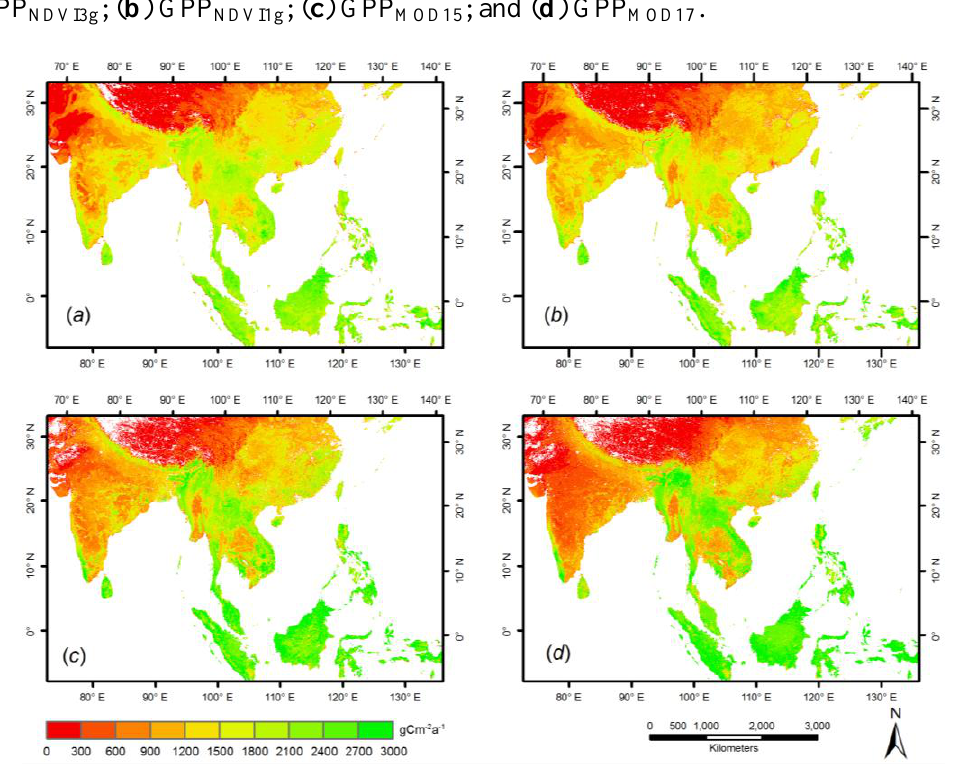
Figure 7. Spatial patterns of the annual average GPP in 2000–2006 in Southeast